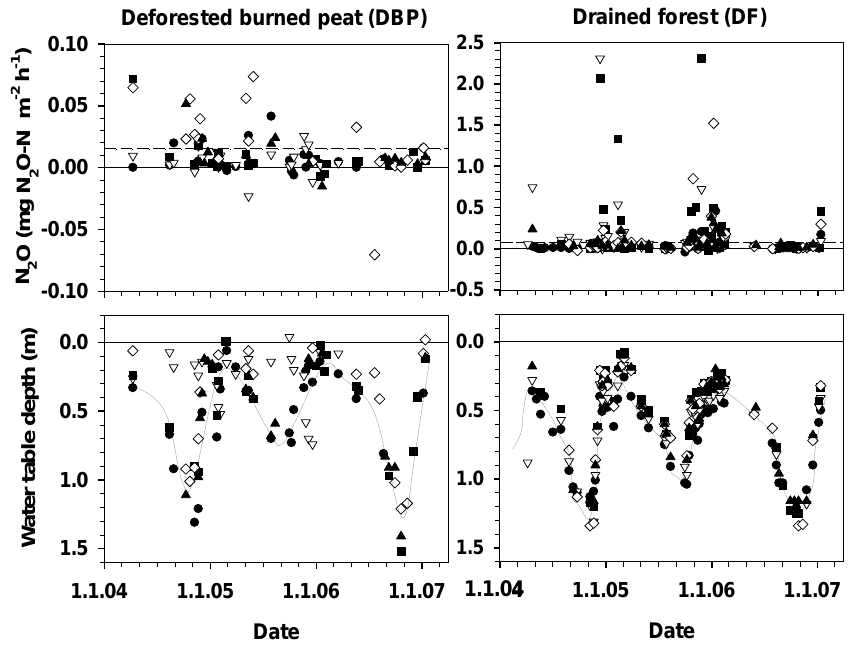
Fig. 4. N 2 O fluxes and the respective water table depth in the gas flux monitoring locations at the 705 DF and DBP sites during the 2004–2007 period. Limits of the highly differing fluxes based on 75% 706 quartiles (dash lines) are; ≥0.0806 (mg N 2 O-N m -2 h -1 ) at the DF site and ≥0.0155 (mg N 2 O-N m -2 h - 707 1 ) at the DBP site. The different symbols denote five gas flux monitoring locations on the site. 708